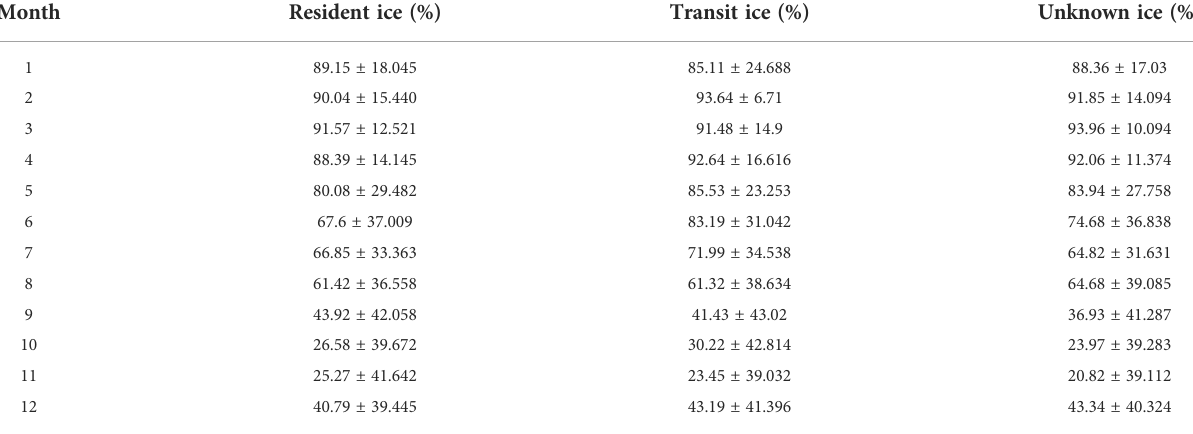
Data are expressed as mean values with standard